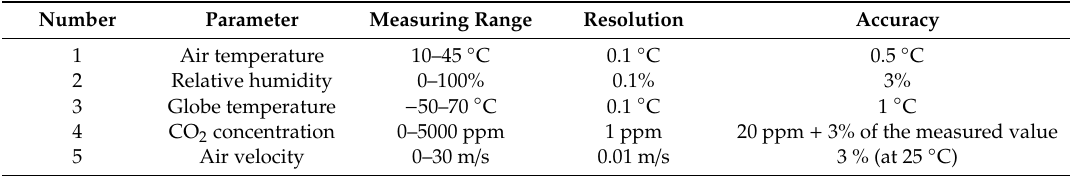
Table 2. Technical details of the measuring system.